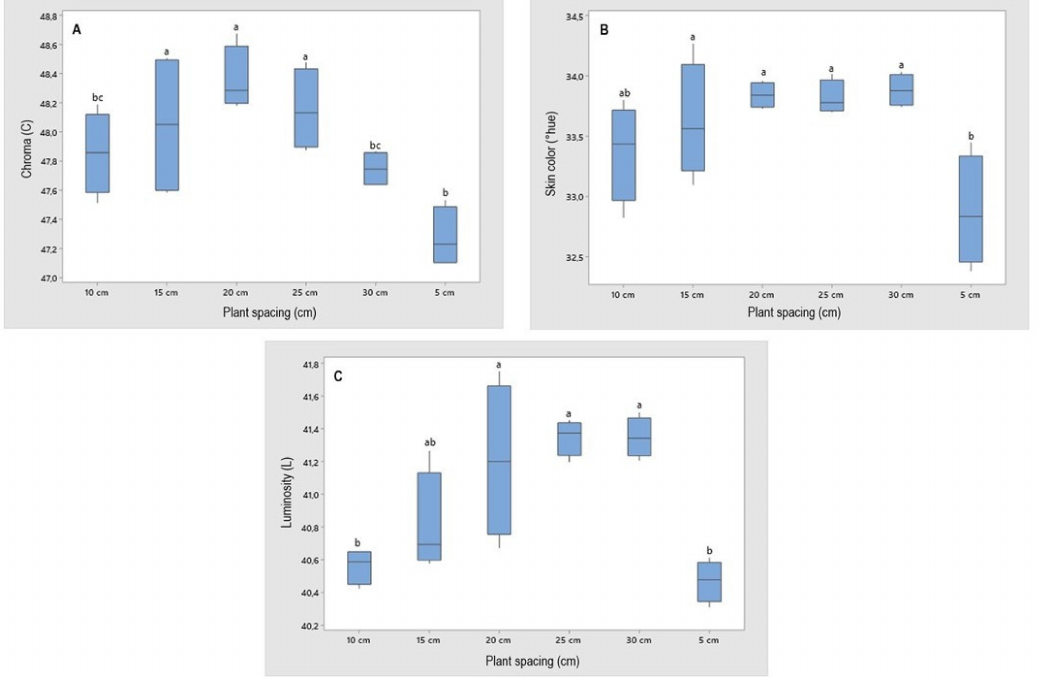
Figure 8. The response to Chroma ( A ), skin color ( ◦ hue) ( B ), and luminosity ( C ) parameters of strawberry plants cv. ‘Pircinque’, in different spacing between with average of the 2018/2019 and 2019/2020 harvests. For each spacing, the different letters indicate significant differences ( p ≤